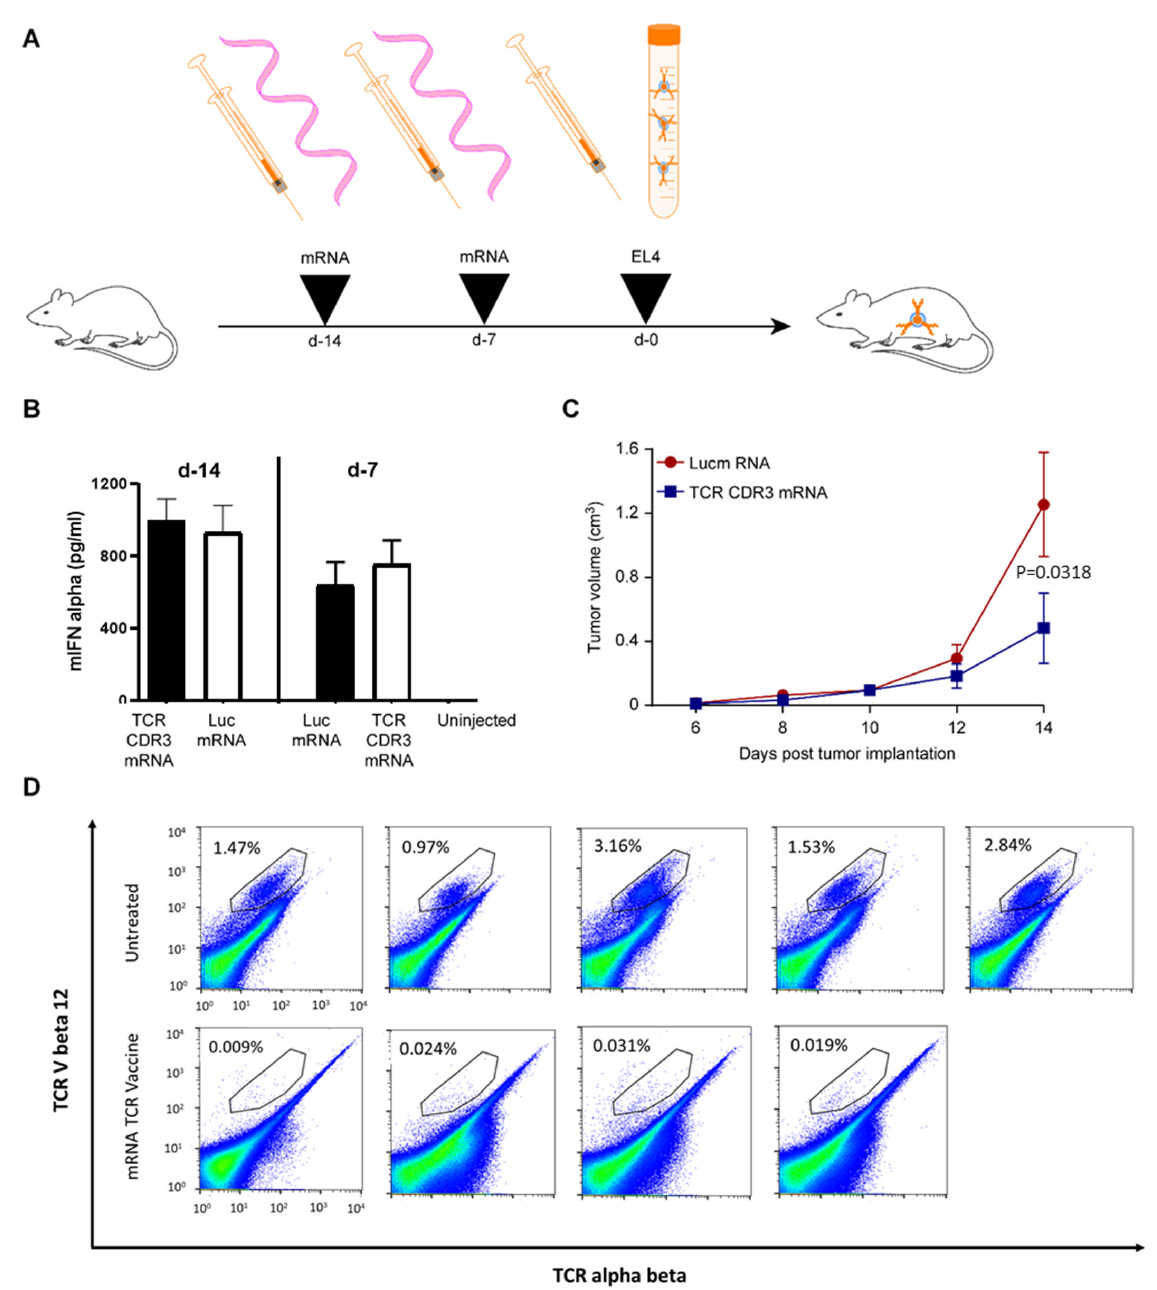
Figure 2. Efficacy of the anti-TCR CDR3 mRNA vaccine in vivo. The synthetic mRNA depicted in Figure 1 was formulated in liposomes and injected intravenously according to the schedule presented in ( A ). Three hours after injection, serum was analysed for interferon-alpha content (five C57BL/6 mice per group). The results are presented in ( B ) for both the priming (d-14) and boost (d-7) vaccines. One week after the boost vaccine, mice (five C57BL/6 mice per group) were implanted subcutaneously with EL4 cells, and the growth of the tumour was measured using a calliper ( C ). A significant (2way ANOVA p -value 0.0318) decrease in tumour growth was observed in the mice vaccinated by the mRNA encoding the CDR3 regions of the EL4 TCR. In a follow-up experiment (Figure A2), tumours were collected. Cells from these tissues were grown for one week in vitro, stained using an anti-mouse TCR antibody and an anti-mouse TCR Vbeta 12 antibody and analysed by FACS ( D ). The percentages of TCR V beta 12 and TCR alpha beta double-positive cells (gate is shown on the dot plots) in the cultures are indicated.